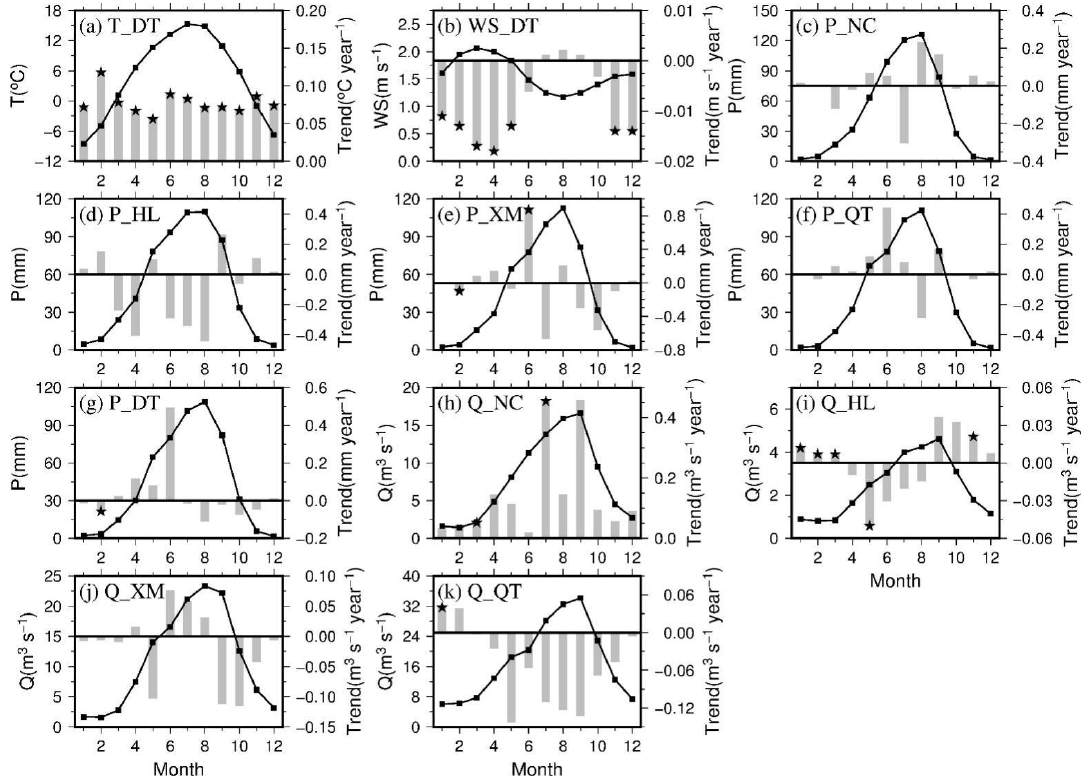
Figure 2. Means and trends of monthly hydrometeorological variables at DT, NC, HL, XM, and QT stations. Curve represents mean monthly values (left y -axis), and bar chart displays monthly trends (right y -axis). Star represents significant trends at 0.05 significance level.